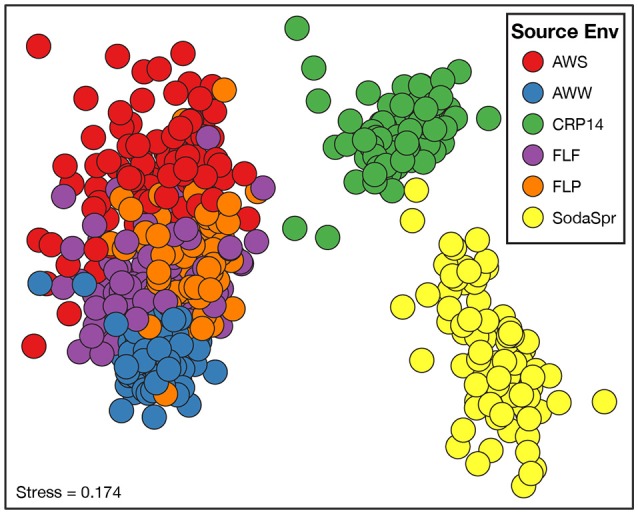
Non-metric multidimensional scaling (NMDS) analysis based on the weighted UniFrac distance metric showing the difference in microbial community structure between the substrate array enrichments.